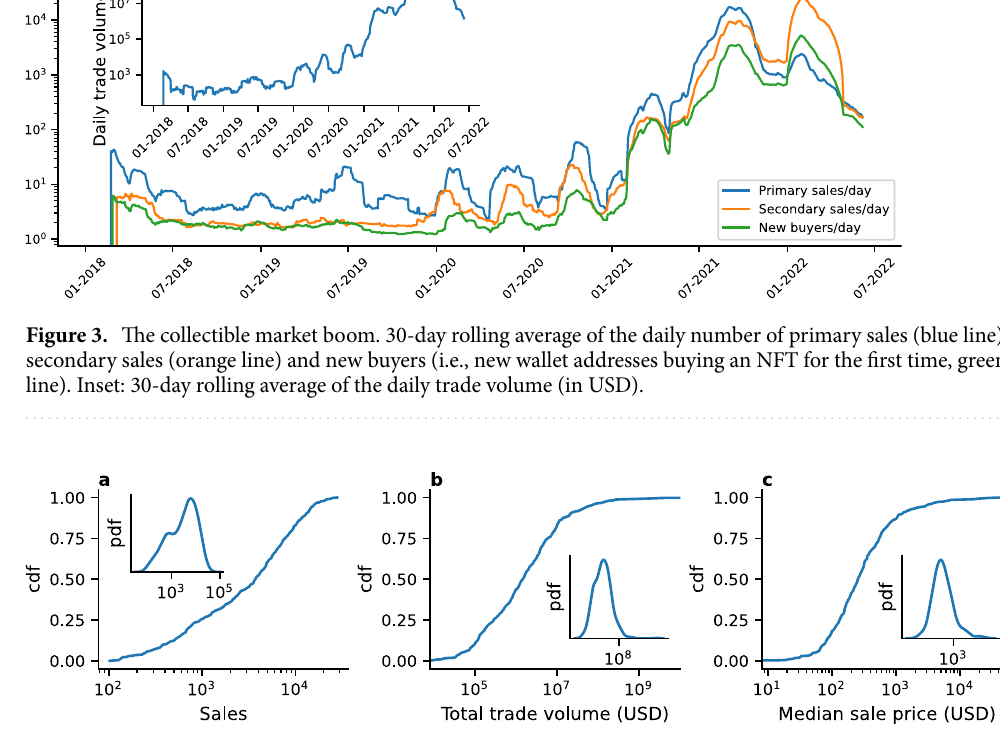
Figure 4. Cumulative distribution of key market properties across collections. ( a ) Total number of sales per collection. ( b ) Total trade volume per collection. ( c ) Median sale price per collection. In inset: Distribution of each market